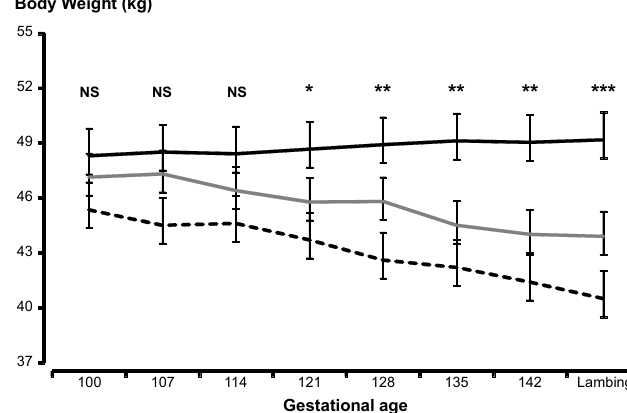
Figure 2. Body weight ( ± SEM) of Rambouillet ewes that received alfalfa (Control; grey line), untreated Opuntia (black solid line), or protein-enriched Opuntia (black dotted line) during late gestation. NS: not significant; *: p < 0.05; **: p < 0.01; *** p < 0.001.